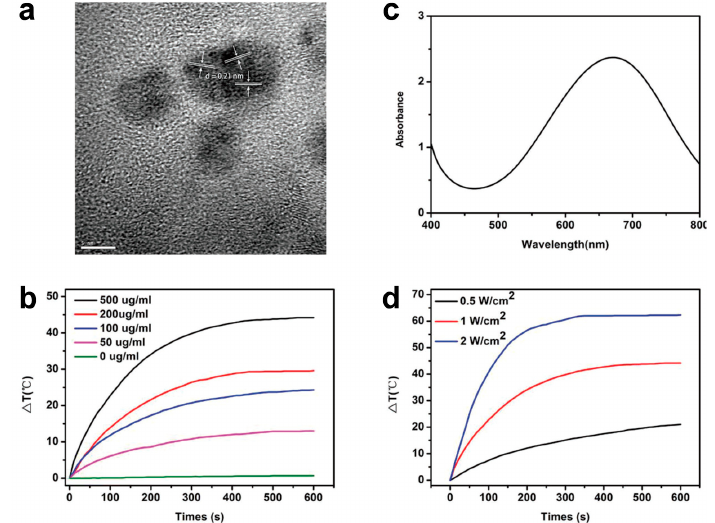
Figure 14. ( a ) High-resolution transmission electron microscopy (HR-TEM) image of supra-carbon nanodots (CNDs). ( b ) Absorption spectra of supra-CNDs in aqueous solution. ( c ) Temperature evolution of various concentrations of supra-CND solutions under 655 nm laser irradiation at a power density of 1 W cm − 2 . ( d ) Temperature evolution of supra-CND solutions (0.5 mg mL − 1 ) at various power densities. Reprinted with permission from [88]. Copyright, John Wiley and Sons (2019).